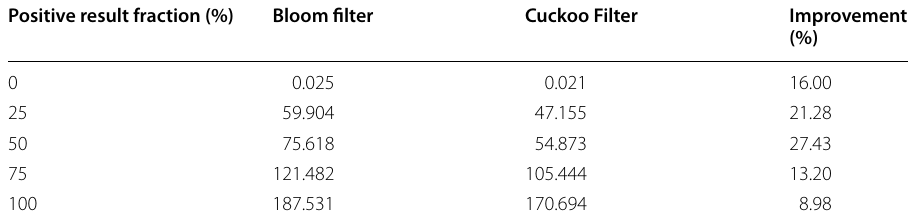
Table 4 Experimental results 1: Lookup performance varying the fraction of queries yielding positive results. Query execution time in